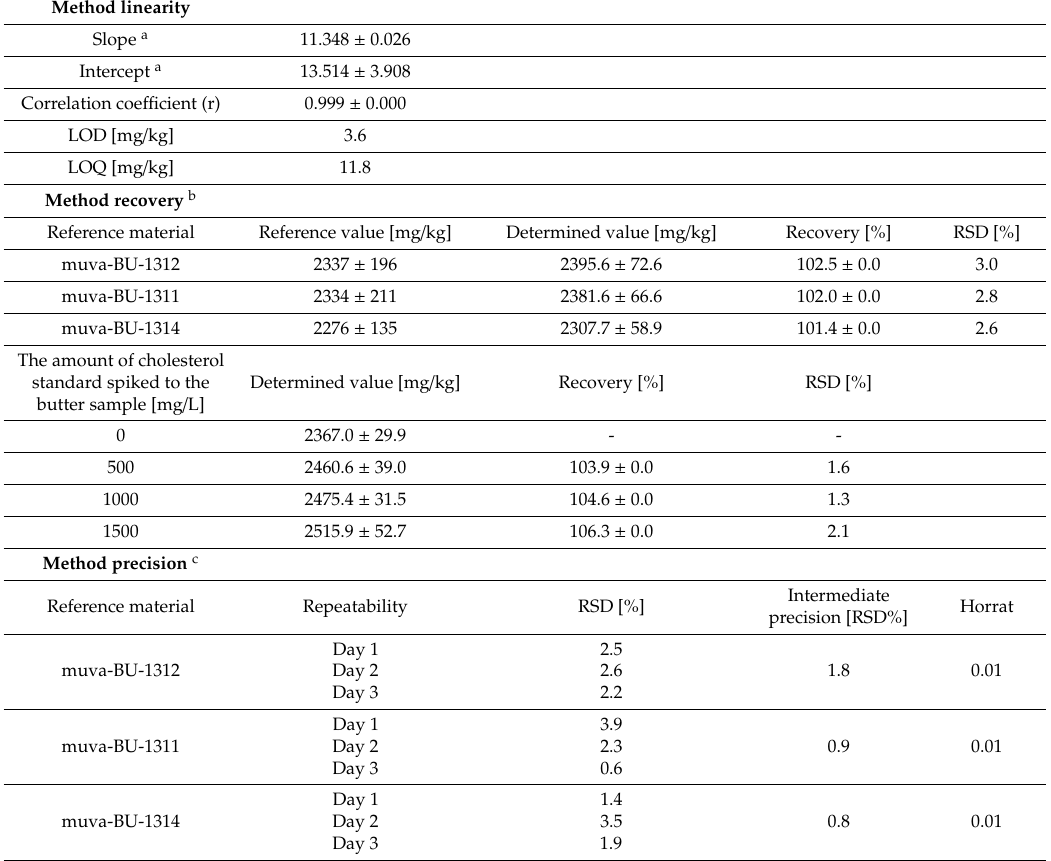
Table 1. Method validation (linearity, recovery, and precision of